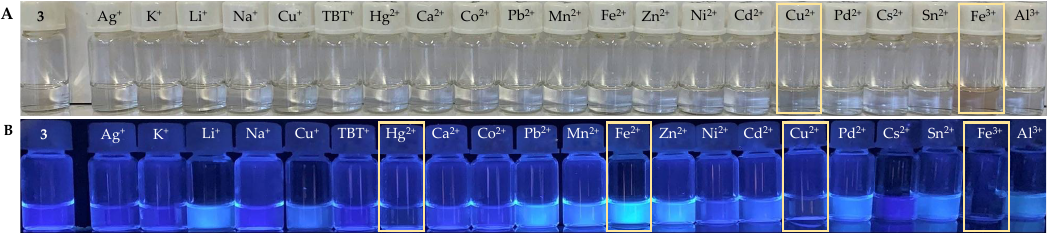
Figure 4. Solutions of compound 3 , in ACN (1 × 10 −5 M), after adding 50 equivalents of cations, under natural light ( A ) and UV radiation at 365 nm ( B ).